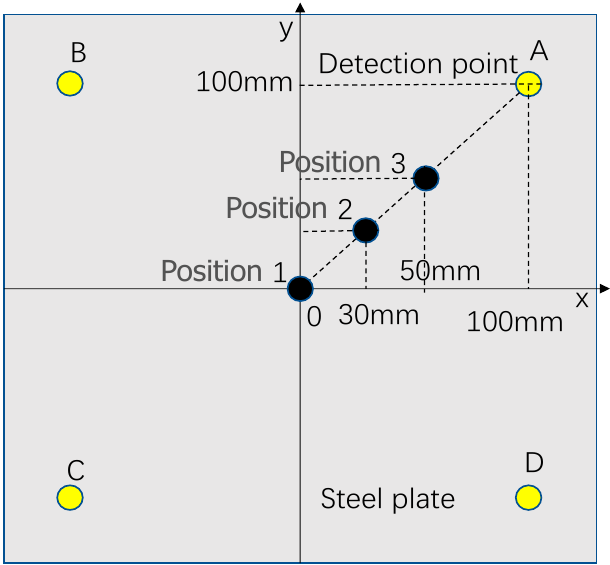
Figure 5. Distribution of impact positions and detection positions.